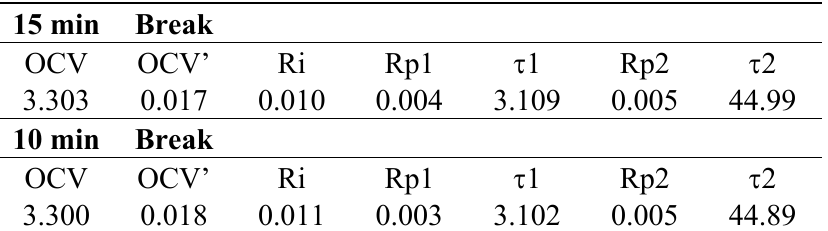
Table 3. Comparison of the simulation results for both scenarios.